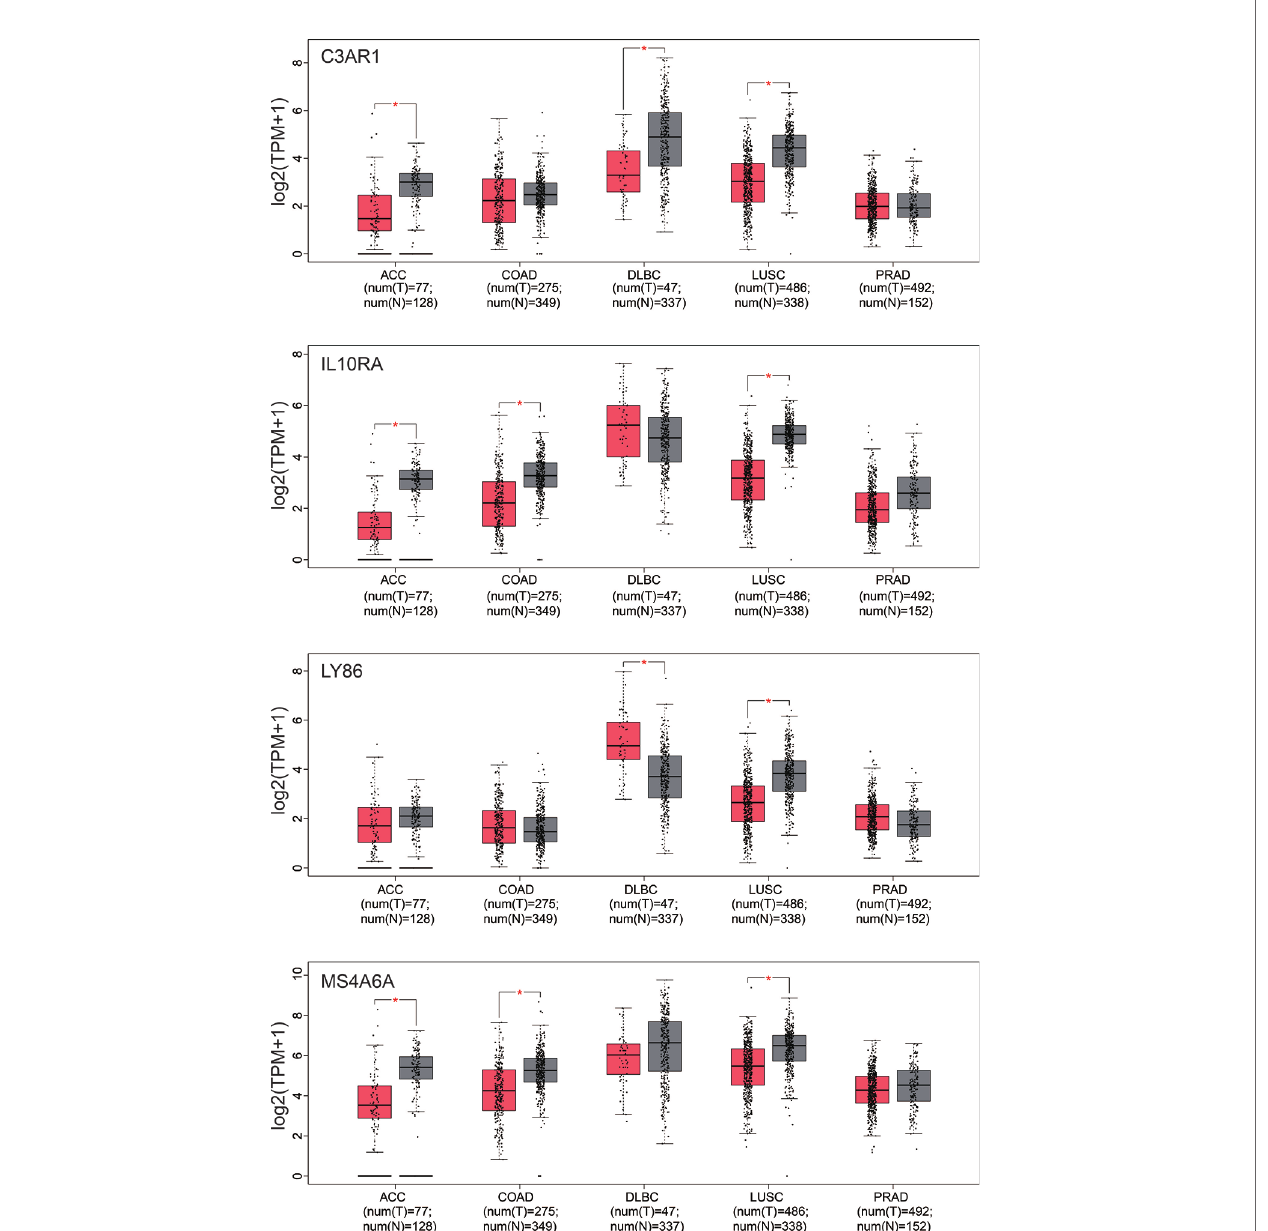
FIGURE 9 | Box-plot of expression values (TMP) of the four hub genes between tumor and normal samples derived from the TCGA datasets. ACC, Adrenocortical carcinoma; COAD, Colon adenocarcinoma; DLBC, Lymphoid Neoplasm Diffuse Large B-cell Lymphoma; LUSC, Lung squamous cell carcinoma; PRAD, Prostate adenocarcinoma. Differential analysis between tumor and normal group was conducted using one-way ANOVA method. *pvalue <